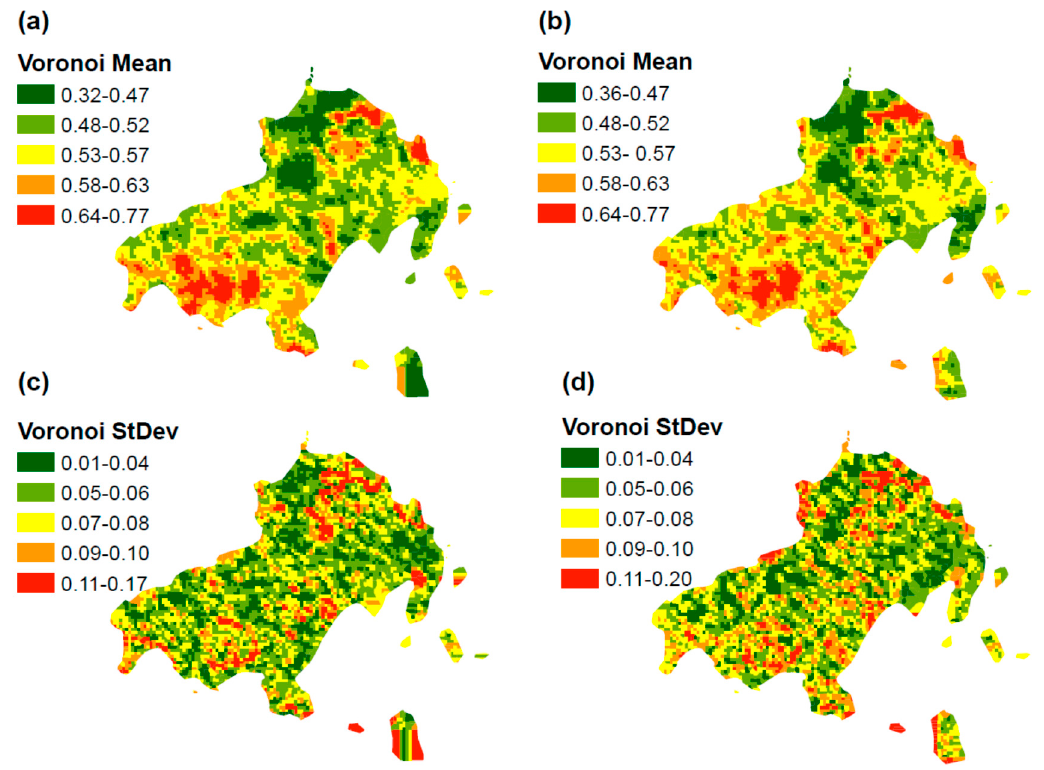
Figure 5. ( a ) Voronoi mean map 1996, ( b ) Voronoi mean map 2016, ( c ) Voronoi standard deviation map 1996, and ( d ) Voronoi standard deviation map 2016.